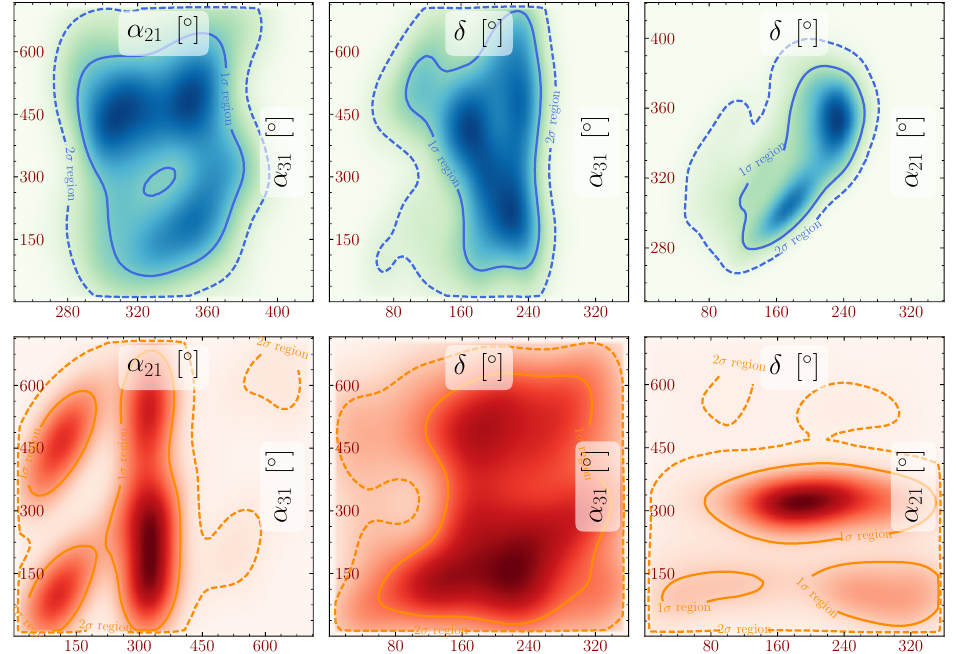
Figure 2 . The two-dimensional projections for leptogenesis with M 1 = 10 10 GeV and CP violation provided only by the phases of the PMNS matrix. The NO case is coloured blue/green and the IO one is orange/red. The contours correspond to 68% and 95% con(cid:12)dence levels. This plot was created using SuperPlot